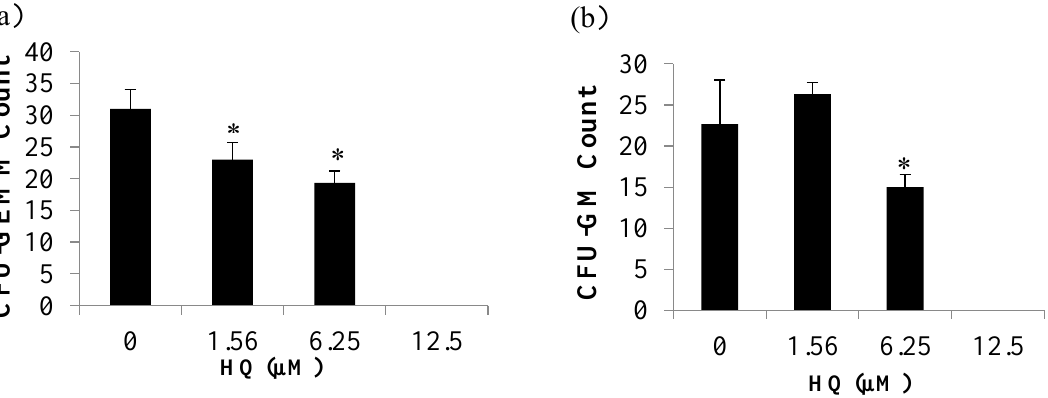
significantly (p<0.05) reduced only at 6.25µM HQ as compared to control group.